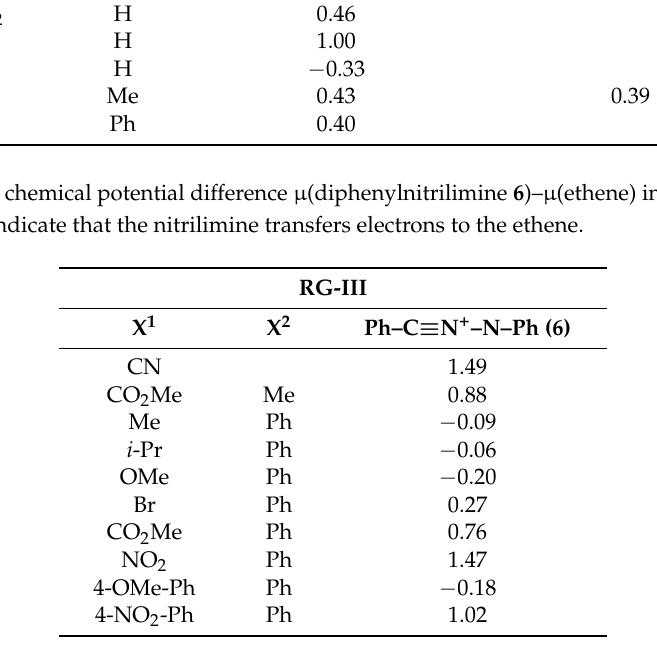
Table 10. Grand potential stabilization difference δ ∆Ω = ∆Ω (5-X 1 ) − ∆Ω (4-X 1 ) (meV) for 1,3-DC of nitrilimines 1 to alkenes. Negative values indicate that the 5-X-pyrazoline regioisomer is favored.